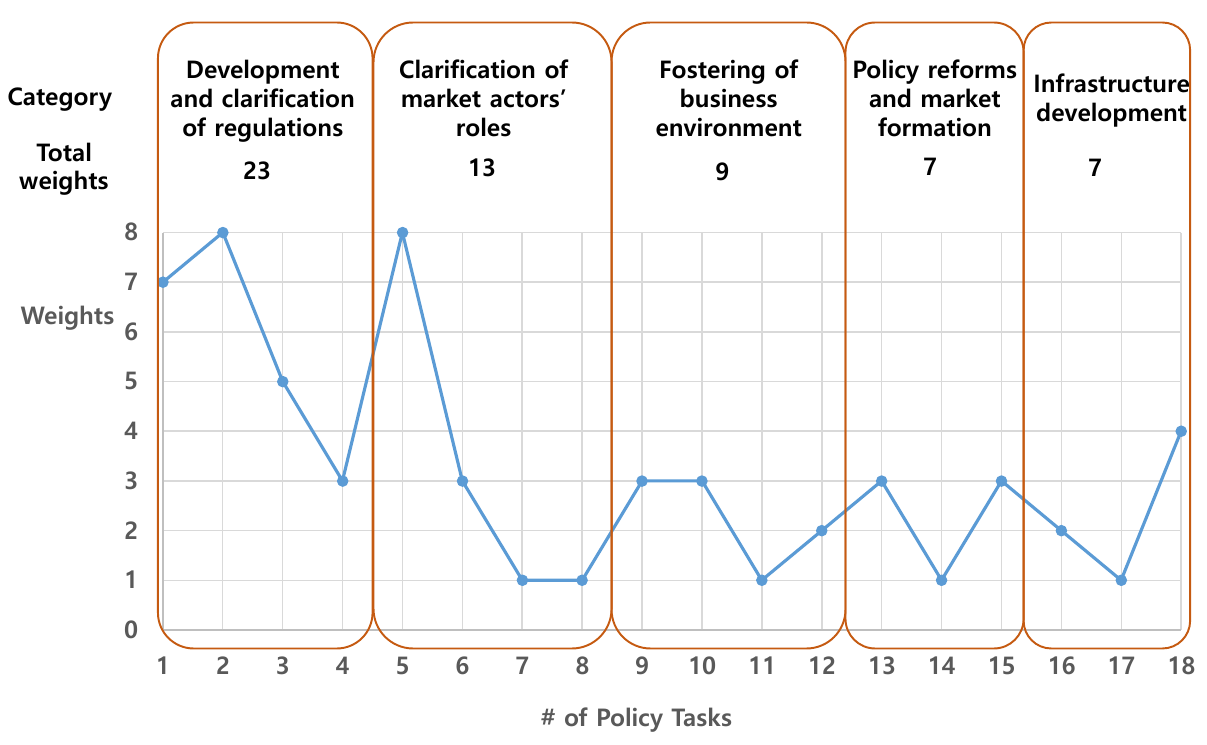
Figure 1. Policy tasks and their weights.